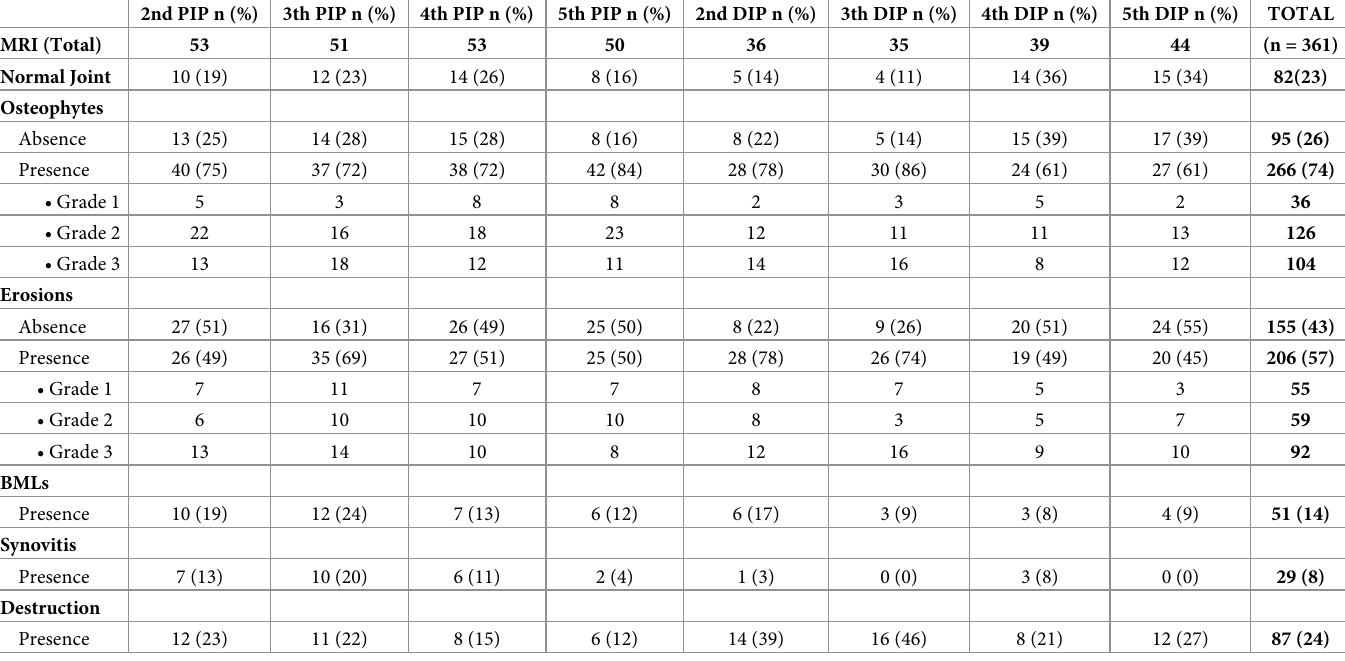
Table 3. The prevalence of MRI in interphalangeal joints of 2th–5th